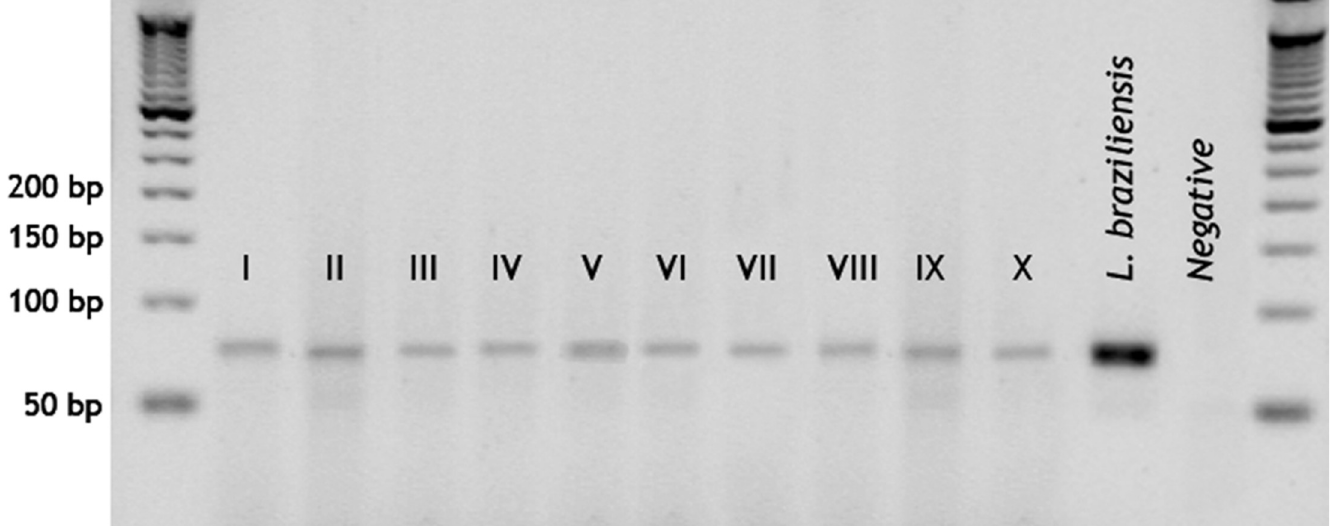
Fig 6. Detection of Leishmania DNA on field collected Lutzomyia by kinetoplast based PCR. Ten pools were confirmed positive for Leishmania by the presence of a characteristic 70 bp band. Lu . (Lutzomyia) spp. (I), Lu . shawi (II-IV), Lutzomyia carrerai carrerai (V), Lu . yuilli yuilli (VI), Lu . (Helcocyrtomyia) spp. (VII and VIII) and Lu . hirsuta hirsuta (IX and